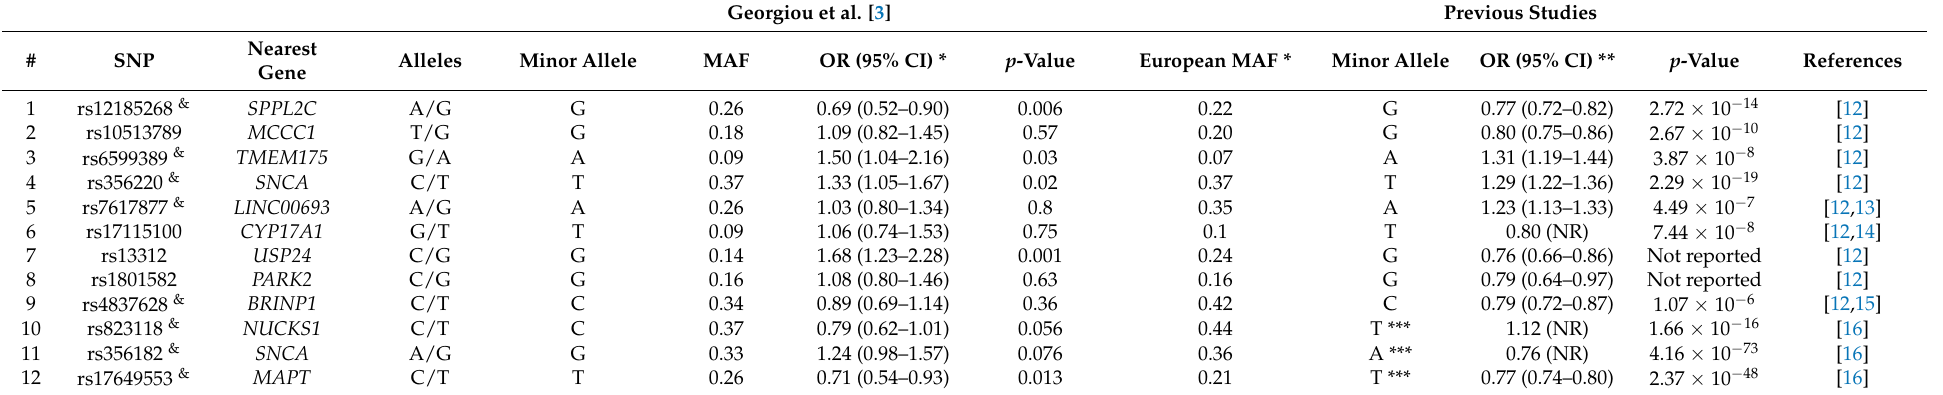
Table 1. Odds ratio (OR) and 95% confidence intervals (95% CI) for the associations between 12 Single Nucleotide Polymorphisms (SNPs) and Parkinson’s disease (PD) risk. Georgiou et al. [3] Previous